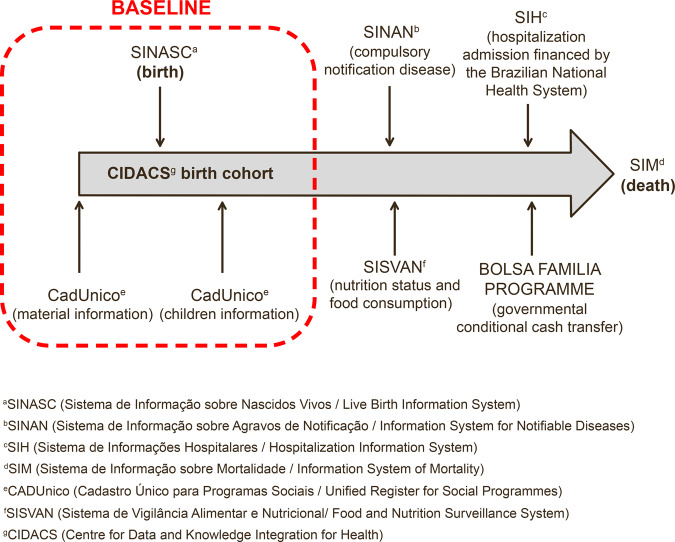
CIDACS birth cohort